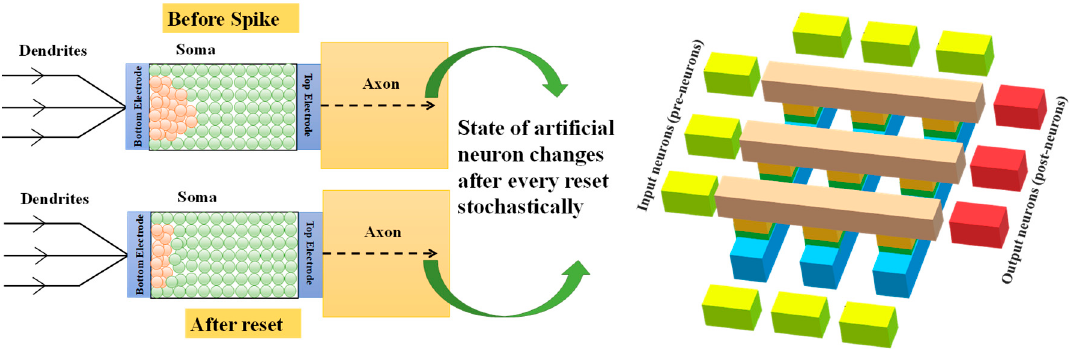
Figure 7. Typical functionality of the actual neuron and pre- and post-neuron crossbar structure.